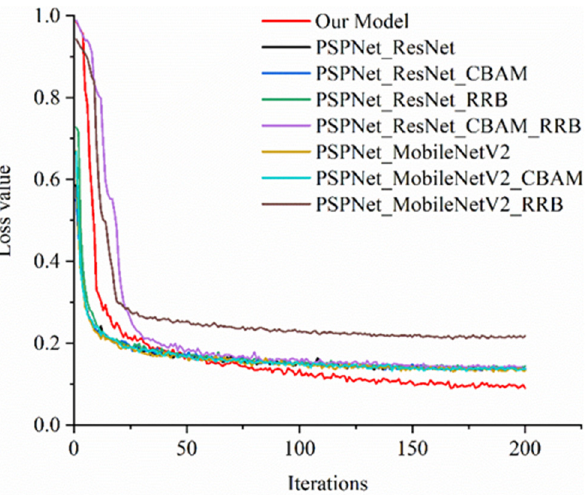
Figure 14. Changes of training set loss value of the model with iteration times.